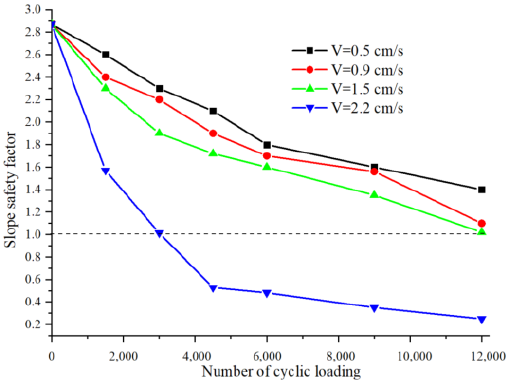
Figure 10. Schematic diagram of section of slope with the slip zone soil. According to the results obtained by analyzing the slope stability, the change of slope safety factor is statistically analyzed under different loading numbers and different loading stress amplitude, whose change is shown in Figure 11 and Table 2.